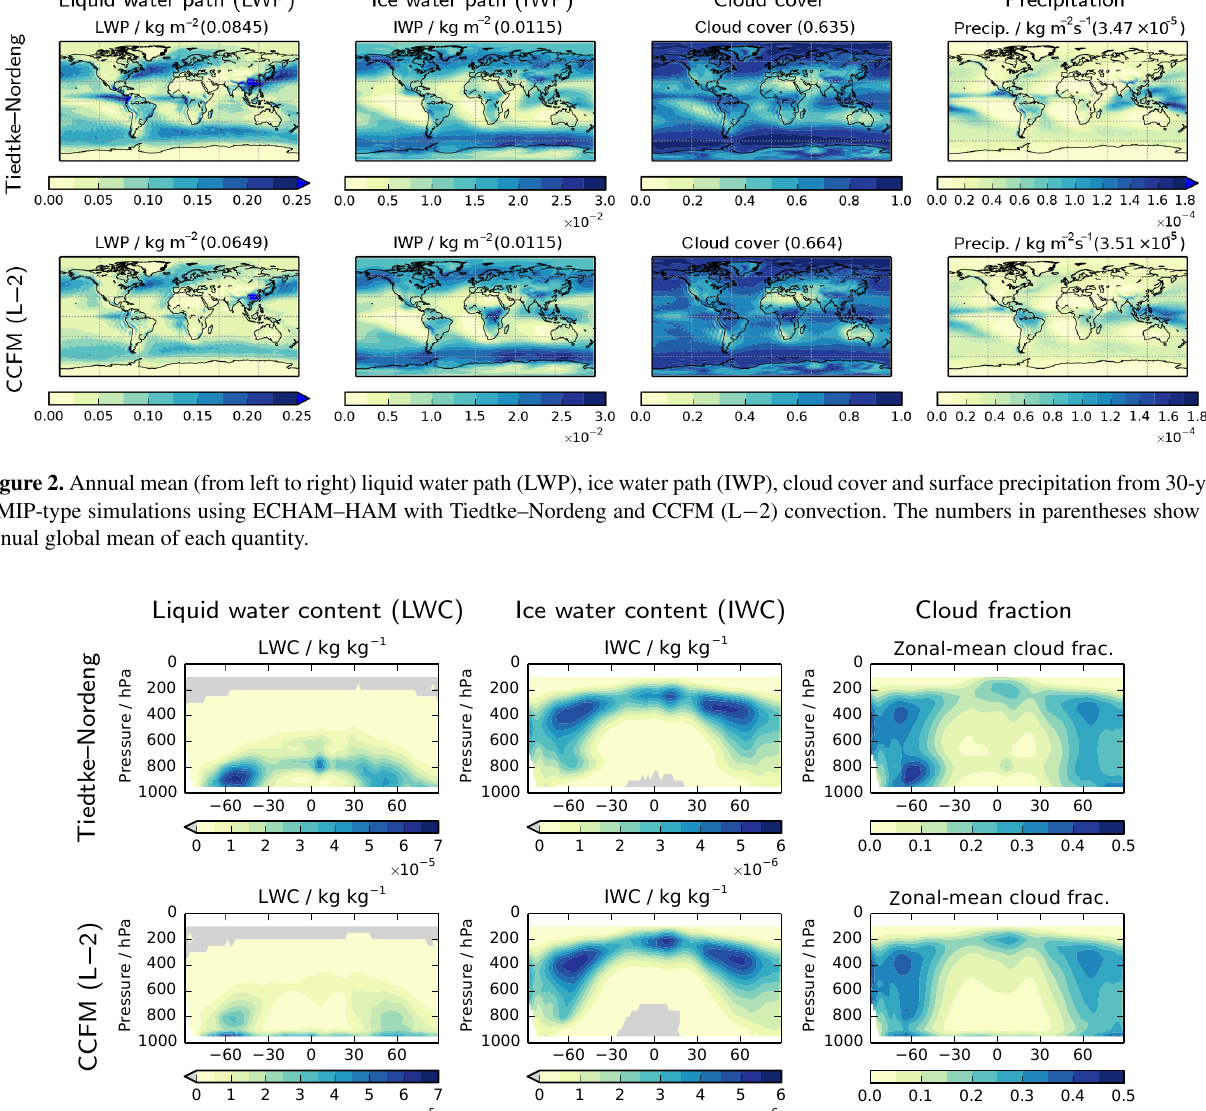
The subcloud model is run for n sub (set to 20) initial